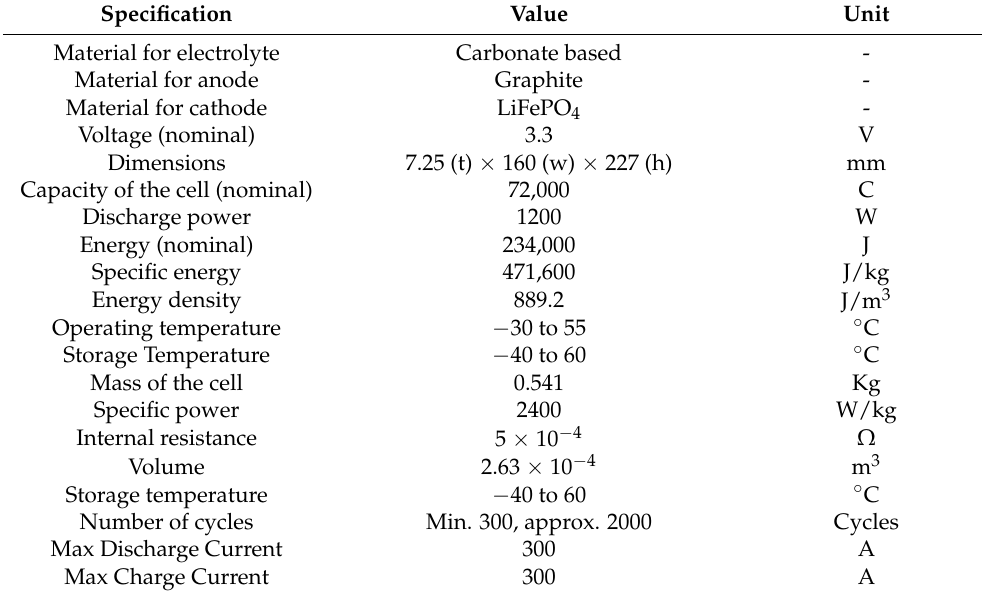
Table 1. Prismatic 20-Ah Lithium-ion (LiFePO 4 ) cell specifications. Adapted from Ref.